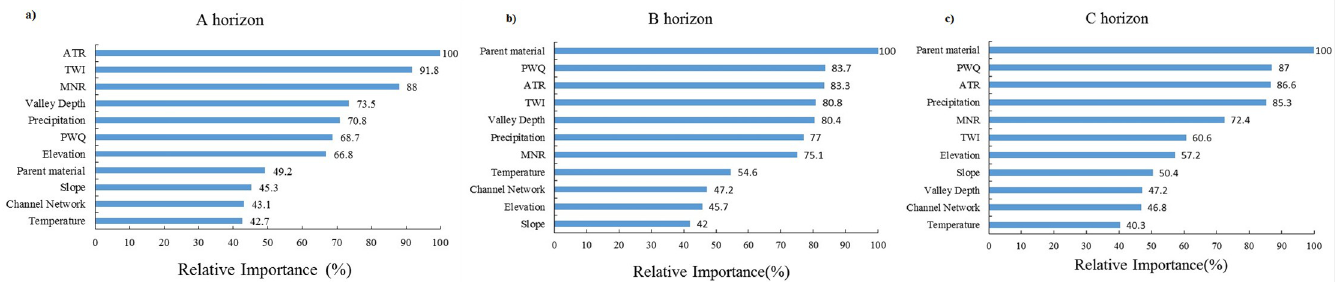
Fig 5. Variable importance rankings produced by CART models for each horizon: a) A horizon, b) B horizon, c) C